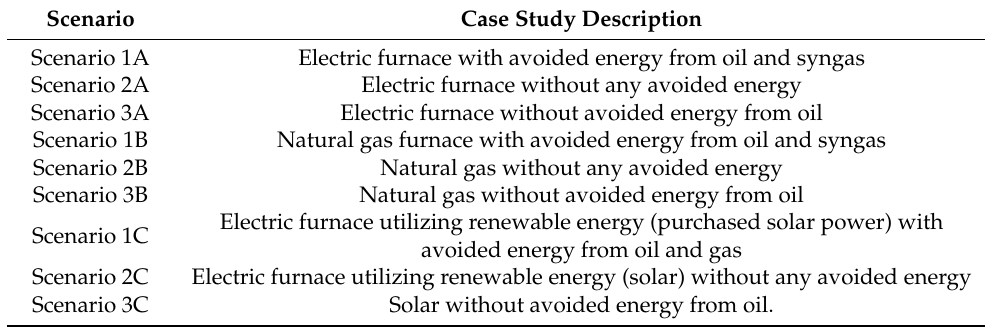
Table 1. Nine scenarios representing various pyrolysis cases considered for this